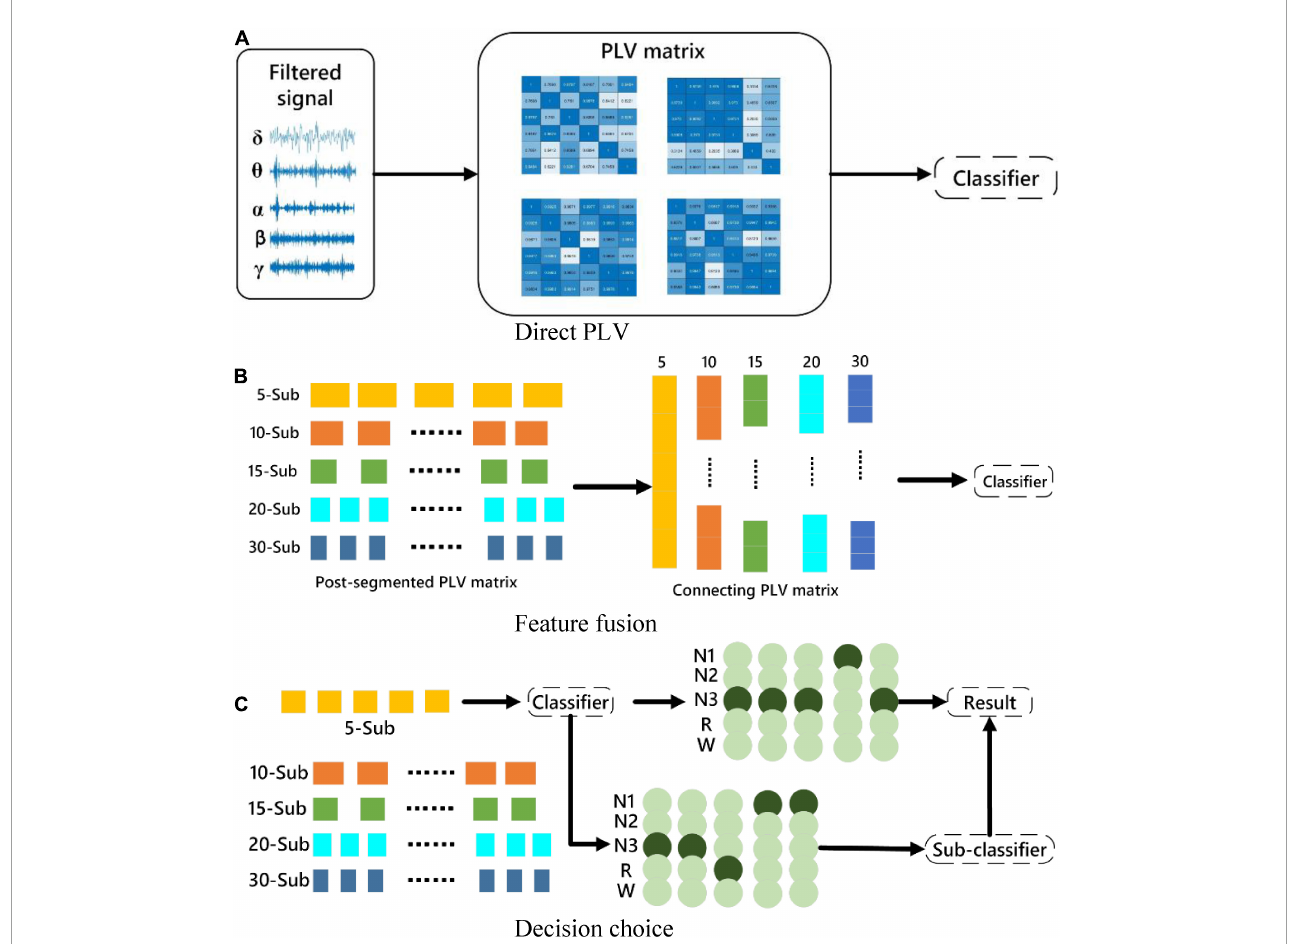
FIGURE3 Schematic diagram of the classification strategy. (A) The original signal is directly subjected to PLV for classification. (B) Feature-level fusion for classification. (C) Multi-sub-segment classification for decision selection.